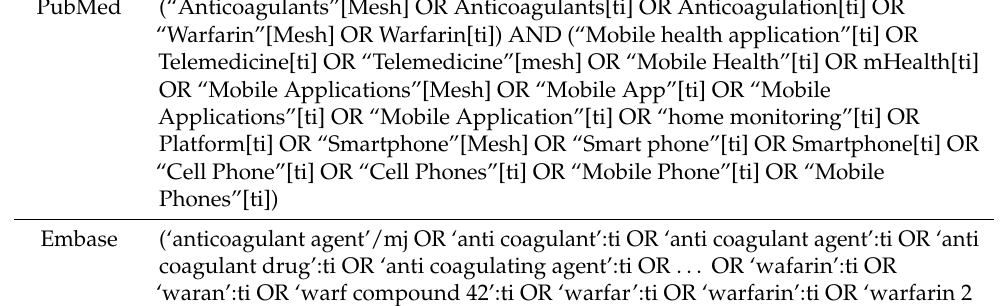
Table 1. Search strategy.